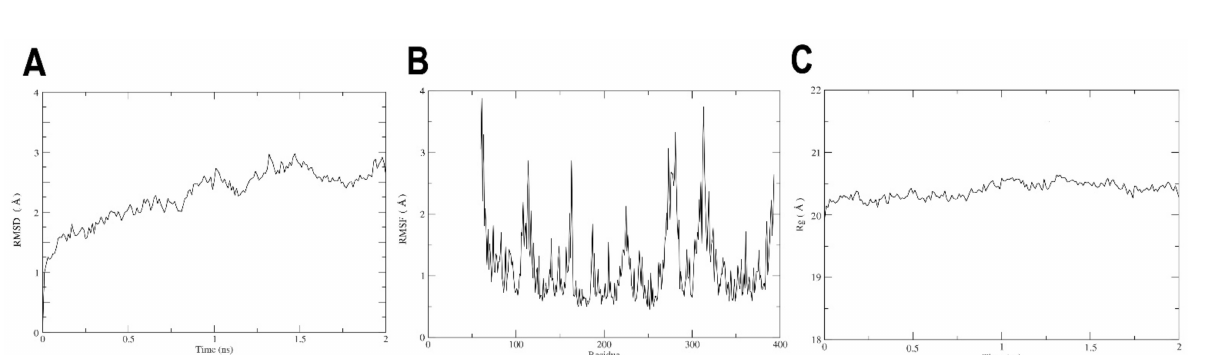
Figure A1. MEK2 modified protein molecular dynamic simulation for 2 (ns). ( A ): Root-mean-square deviation (RMSD) curve for the protein backbone. RMSD plot provides quantification of the overall stability of the protein backbone during 2 ns simulation. From the graph we can see the values range between 1–2.5 Å for MEK2. ( B ): Root-mean-square fluctuations (RMSF) curve of the MEK2 residues. The highest fluctuation was in the missing loop area up to 4 Å for MEK2 which is originally high flexible region and the others resides seem to be fluctuate in only around 2 Å. ( C ): Radius of gyration (total) of the protein. The graph shows the protein gyrate only around 20 Å for MEK2, moreover no big changes through the 2 ns simulation which indicate the stability of the shape of